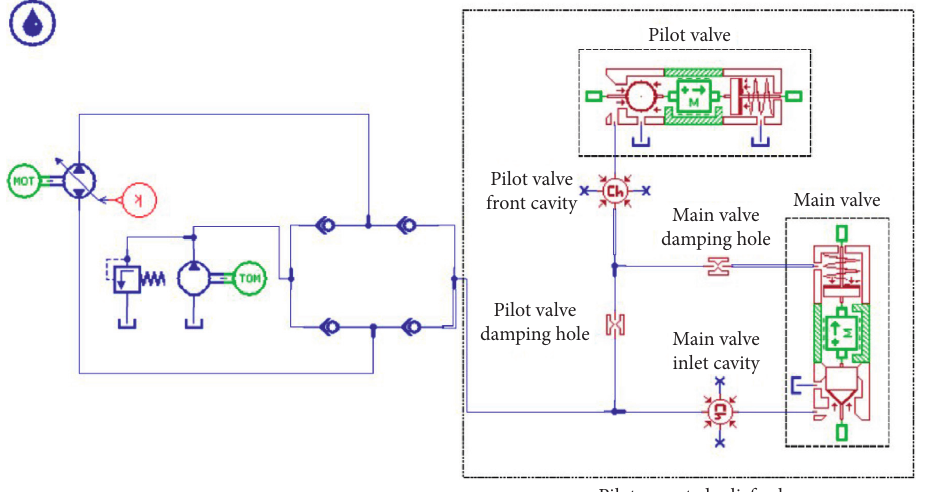
Figure 3: AMESim simulation model of hydraulic loading